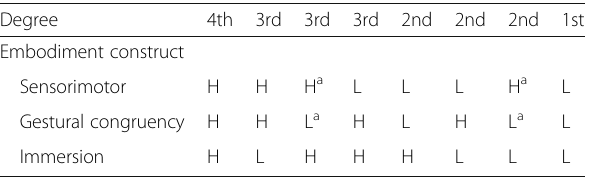
Table 1 Construct magnitude within degrees in the